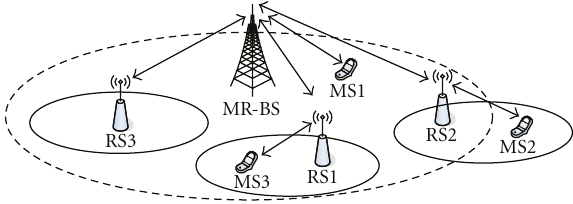
Figure 1: MultiHop relay-enhanced